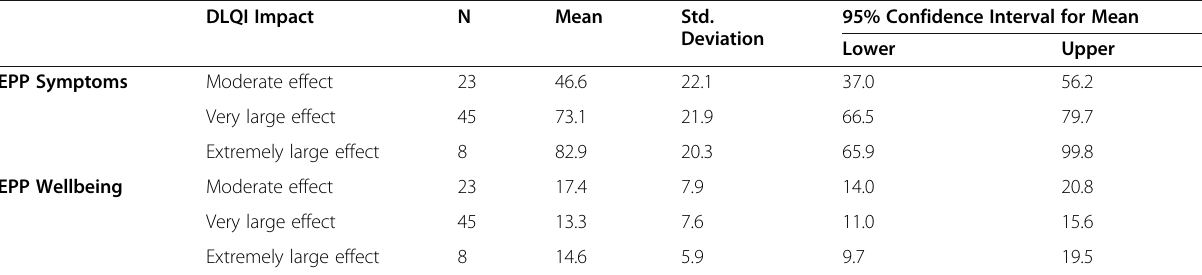
Table 2 Mean (and standard deviation, 95% confidence intervals) of EPP-QoL domain scores separated by degree of impact of EPP (determined by DLQI score)